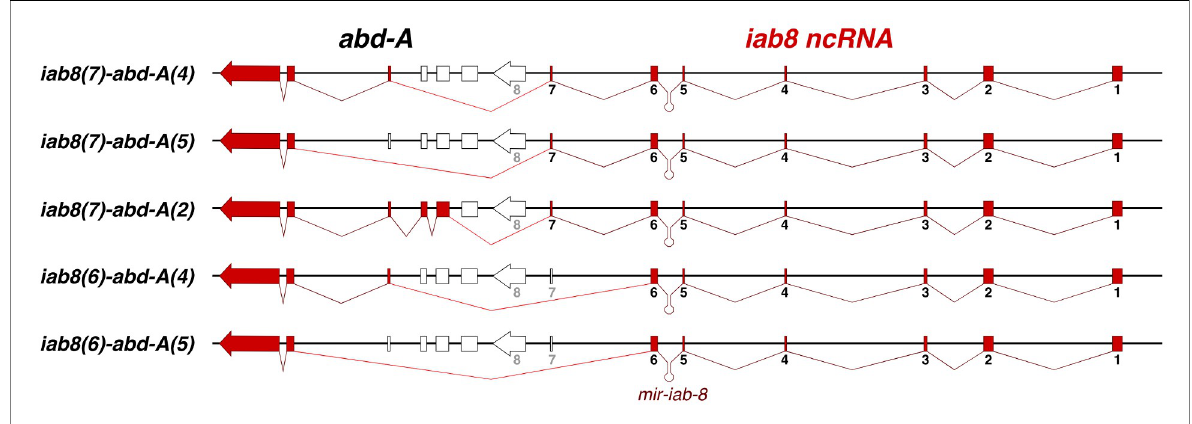
Fig 3. Splice variant found between the iab-8 ncRNA and abd-A transcription units in the CNS. A schematic representation of the genomic region is shown with the different exons represented by broken block arrows. The utilized exons of the iab-8 ncRNA are shown in red and the utilized exons of abd-A are shown in pink. Unused exons are white. The different splice products are shown by the red lines between exons.